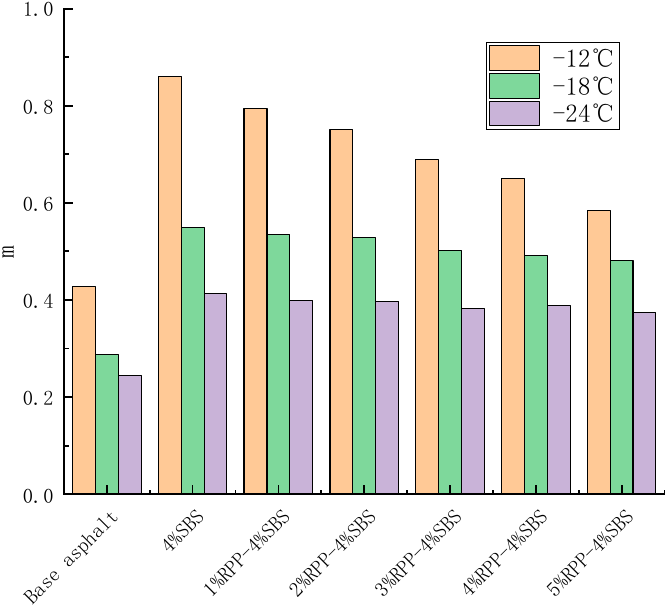
Figure 15. Effect of RPP content on the creep rate of modified asphalt.